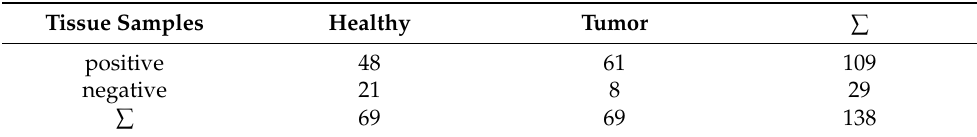
Table 2. Descriptive analysis of ZP2 expression in human colon cancer and intraindividual matched control tissues as revealed by real-time PCR and agarose gel electrophoresis. Four separate RT-PCR experiments per tissue sample were performed. The data result in a sensitivity of 88% (61 positives out of 69) and a specificity of 30% (48 positives in controls) for